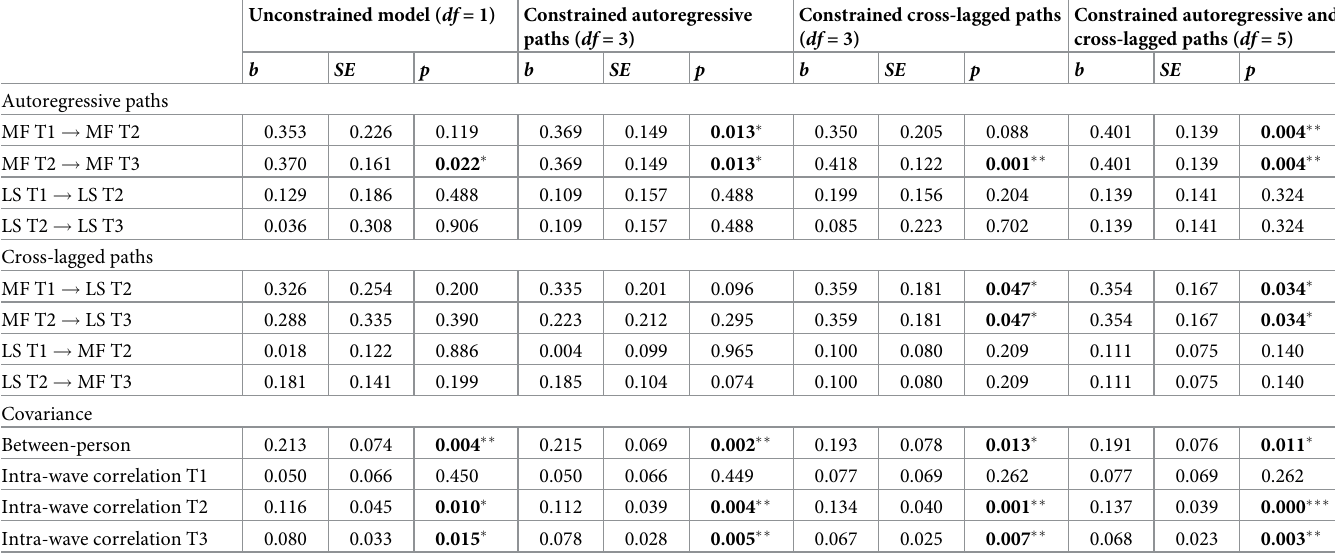
Table 11. Reciprocal relationships between mindfulness and life